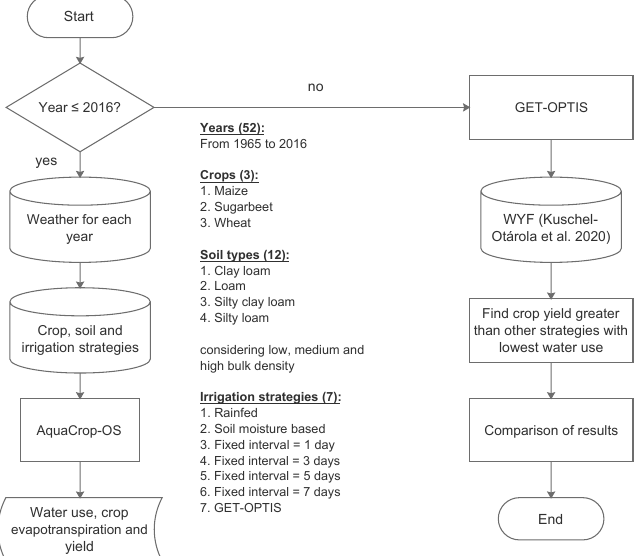
Figure 1. Methodology used in this research to calculate water use, crop yield, and water-use efficiency (WUE) for each irrigation strategy using